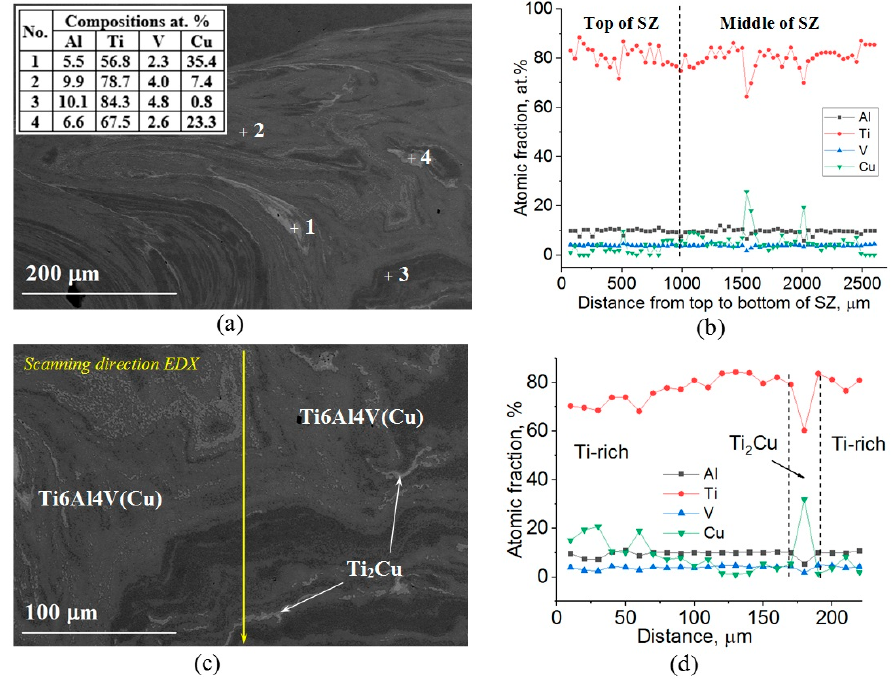
Figure 6. SEM BSE images of the Ti6Al4V/Cu composite SZ ( a , c ), middle part and EDS analysis of the SZ along its height ( b ), as well as a high-copper local area ( d ). TEM images obtained from the SZ of FSPed Ti6Al4V/Cu supported the data obtained from the SEM. The top SZ1 was composed of fine equiaxed α -Ti and β -Ti grains, as well as β -Ti with acicular and laminar α -Ti grains (Figure 7a). Along with the above-named grains, there were fine-grain boundary α -Ti laths ( α -GB) and Ti 2 Cu IMCs (Figure 7b). ( a )